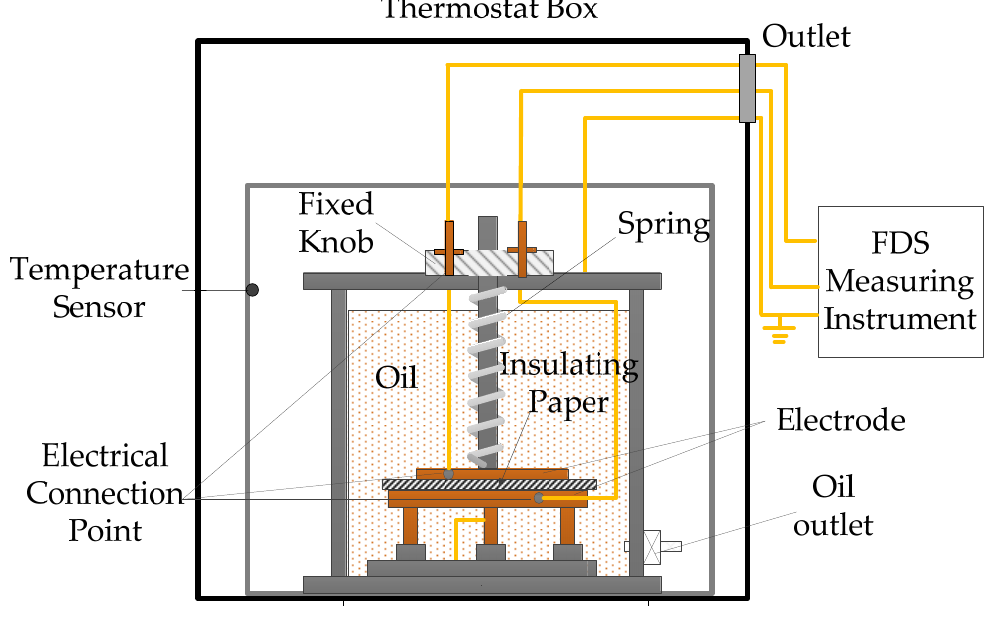
Figure 1. The principle diagram of FDS test device.